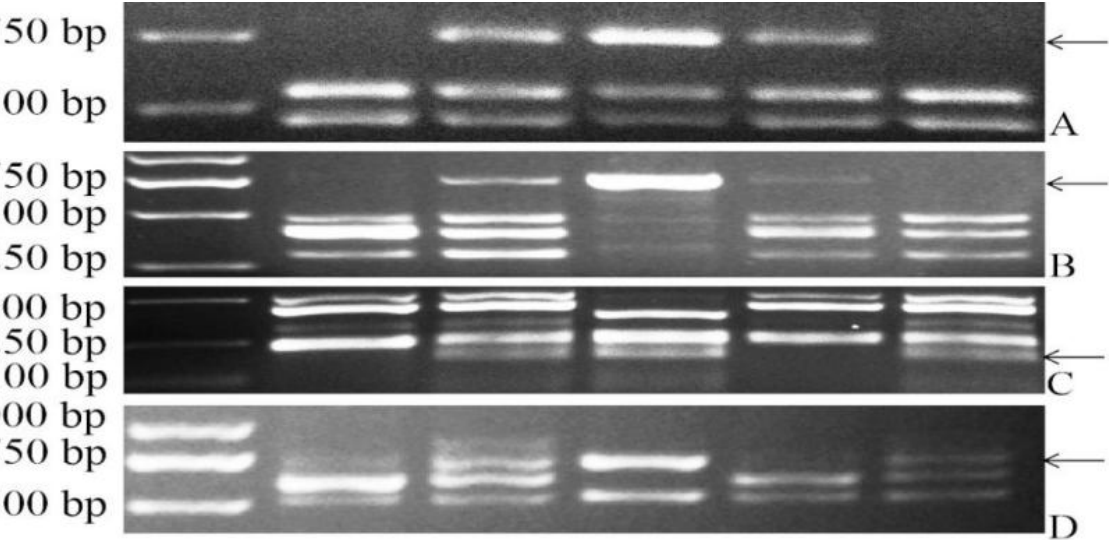
Figure 2. PCR products of PLUG markers in CS, CD-3, D. villosum , 22-12 and 24-20. ( A – D ) PCR amplification generated by the markers TNAC1248, TNAC1326, TNAC1267 and TNAC1359 respectively; M, Trans2k plus DNA markers (TransGen Biotech, Beijing, China); 1, common wheat CS “Chinese Spring”; 2, CD-3; 3, D. villosum ; 4, 22-12; 5, 24-20. The arrows indicate D. villosum -specific bands.